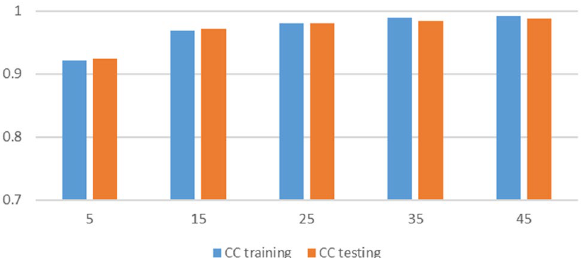
Figure 5. Sensitivity analysis on the number of neurons.